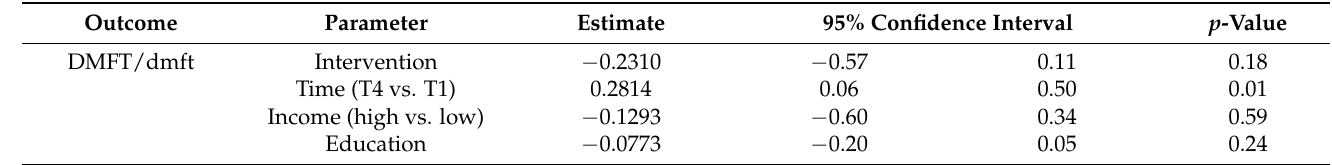
Table 2. Multivariate analyses of the predictors of the DMFT/dmft outcome. Outcome Parameter Estimate 95% Confidence Interval p -Value DMFT/dmft Intervention